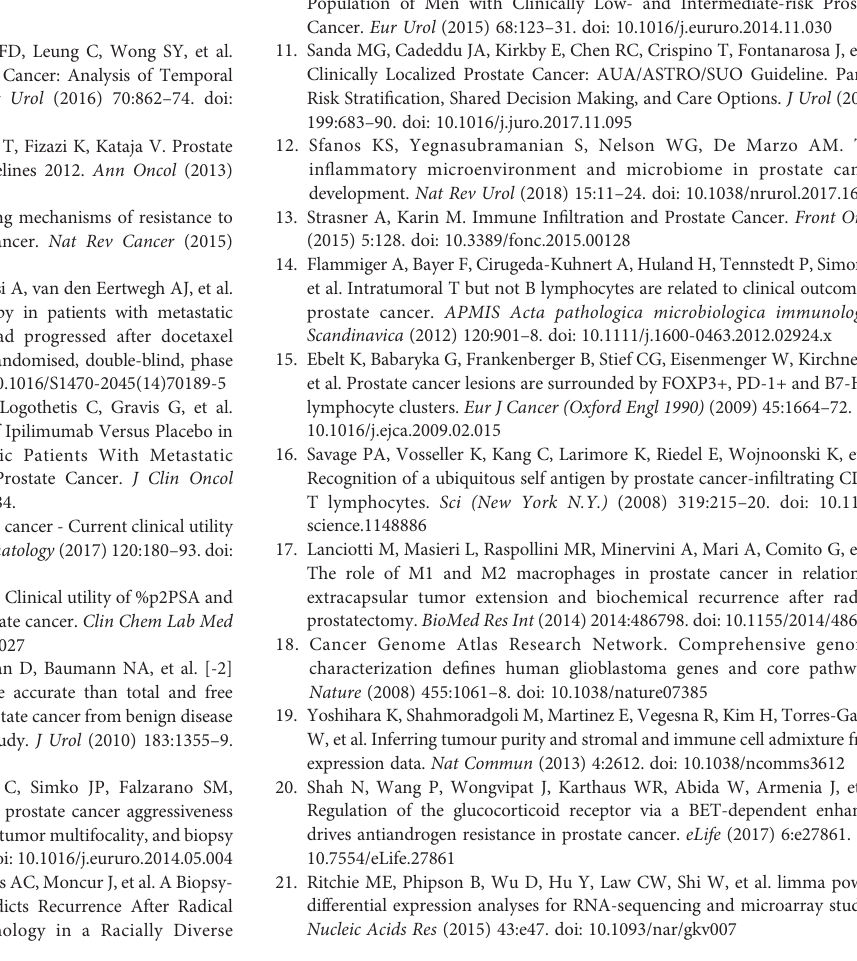
SUPPLEMENTARY FIGURE 3 | Survival rate of the top 30 hub genes ’ high- express group and low-express group. SUPPLEMENTARY FIGURE 4 | Expression level of CXCR4 and GPR183 among different tumor status (T0, T1, T2, N0, N1 and M0, M1) of PCa patients. SUPPLEMENTARY FIGURE 5 | Expression level of CXCR4 and GPR183 between tumor and paired normal tissue of prostate from PCa patients. This data is re-analysied by us according to the GEO dataset GSE69223. SUPPLEMENTARY FIGURE 6 | Expression level of CXCR4 and GPR183 in PCa tissuebetween recurrent and non-recurrent patients. This data is re-analysied by us according to the GEO dataset GSE25136. SUPPLEMENTARY FIGURE 7 | Expression level of CXCR4 and GPR183 in blood between castration resistant patients and non-resistent patients. This data is re-analysied by us according to the GEO dataset GSE37199. SUPPLEMENTARY FIGURE 8 | Gene set enrichment analysis (GSEA) for the CXCR4 high-expressed group of PCa. Top10 enriched KEGG pathways are shown in this fi gure. SUPPLEMENTARY FIGURE 9 | Gene set enrichment analysis (GSEA) for the GPR183 high-expressed group of PCa. Top10 enriched KEGG pathways are shown in this fi